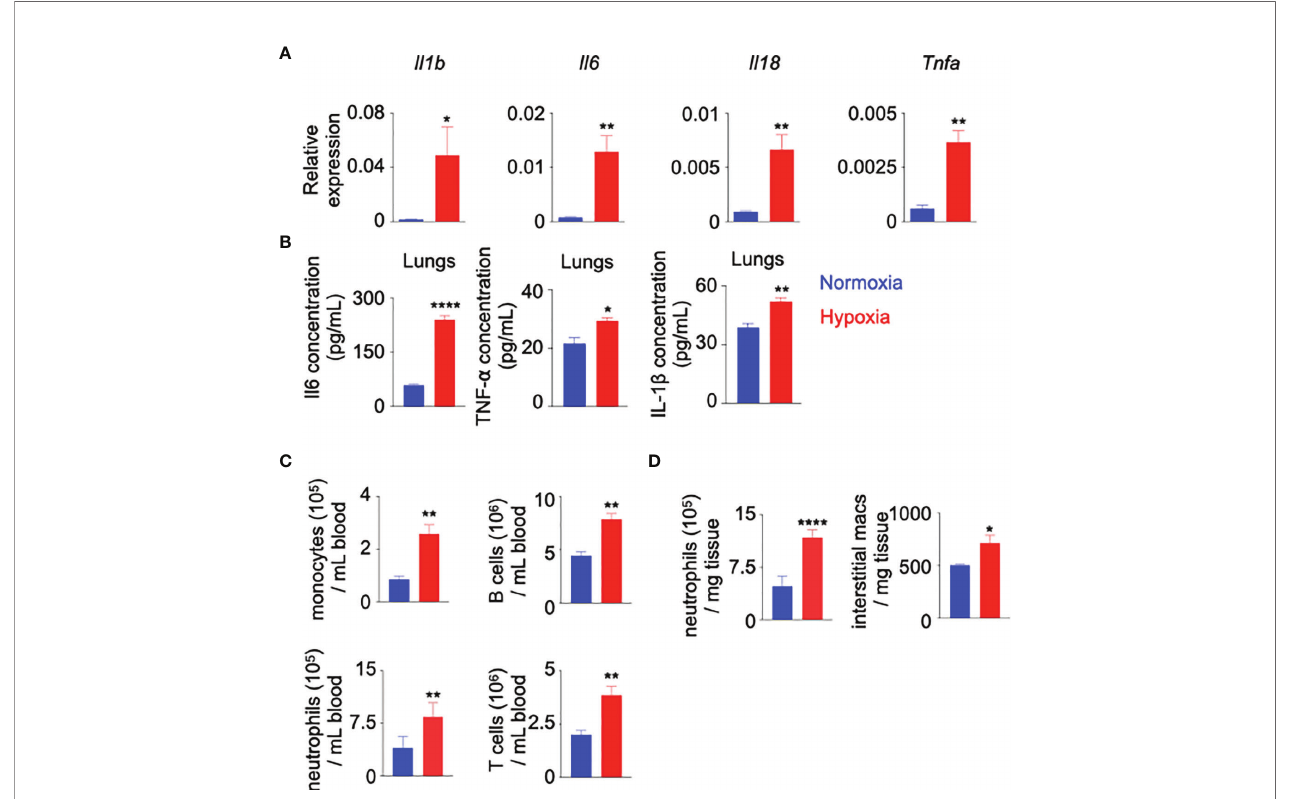
FIGURE 1 | Hypoxia induces in fl ammation. C57BL/6 mice were placed under either normoxic or hypoxic conditions for 21 days. Lungs, blood and bone marrow were collected. (A) Il1b, Il6, Il18 and Tnfa expression was assessed by RT-qPCR. (B) Il-6, TNF- a and IL1- b protein expression was evaluated in the whole lung and serum by ELISA. (C) The numbers of blood monocytes, neutrophils, B and T cells in hypoxic versus normoxic mice were determined by fl ow cytometry. (D) The numbers of lung in fi ltrating neutrophils and interstitial macrophages in these mice were quanti fi ed by fl ow cytometry. n = 5 mice per condition. Data are shown as mean ± s.e.m. *P < 0.05, **P < 0.01, ****P <